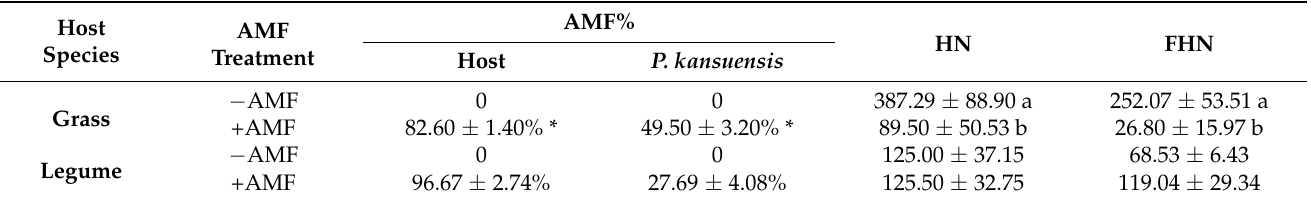
Table 1. AM colonization level (AMF%) of host and Pedicularis kansuensis and number of huastoria (HN) and number of functional haustoria (FHN) produced by P. kansuensis in different treatments.